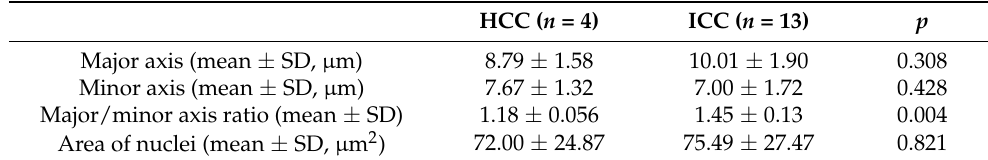
Figure 5. Comparison of major minor axis ratio in hepatocellular carcinoma (HCC) and intrahepatic cholangiocarcinoma (ICC) by validation Papanicolaou-stained clinical samples. A significant difference was found in the major/minor axis ratio between HCC and ICC ( p = 0.004). Table 5. Comparison of Nuclei of HCC and ICC for Each